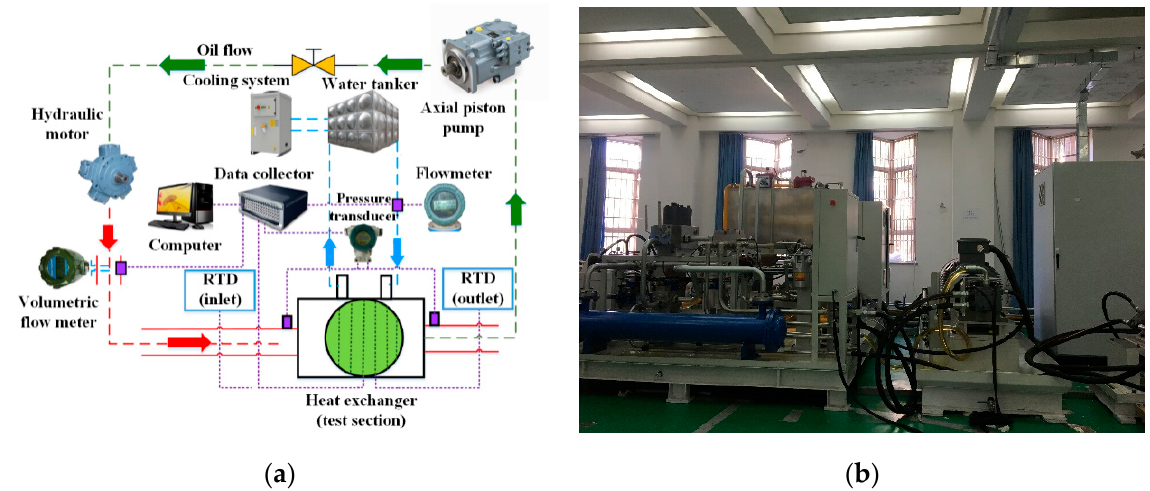
Figure 6. Test rig established at Wenzhou University. ( a ) Schematic of the experimental system. ( b ) Photographs of the test rig.